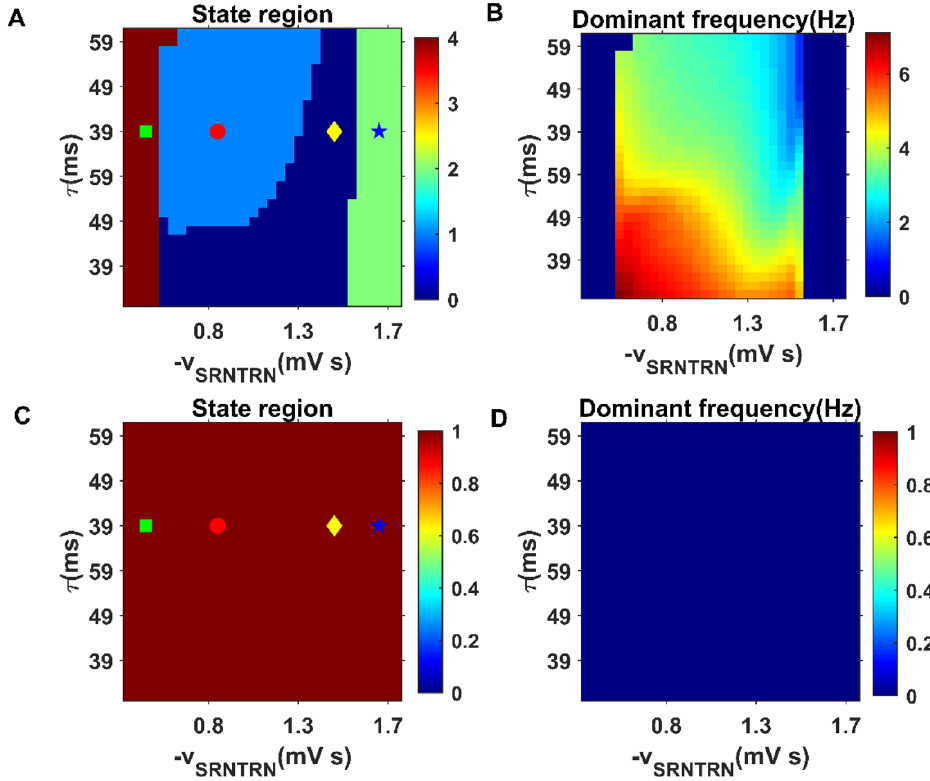
Figure 5. State (left) and dominant frequency (right) diagrams of the cerebral cortex in absence epilepsy model. The initial state and dominant frequency are shown in ( A , B ) respectively, while the state and dominant frequency with DBS stimulation is shown in ( C , D ) respectively. Different color regions in ( A ) represent different discharge states and are marked by different symbols: saturation state (green filled square), SWDs oscillation state (red filled circle), simple oscillation state (yellow filled diamond), low firing state (blue filled